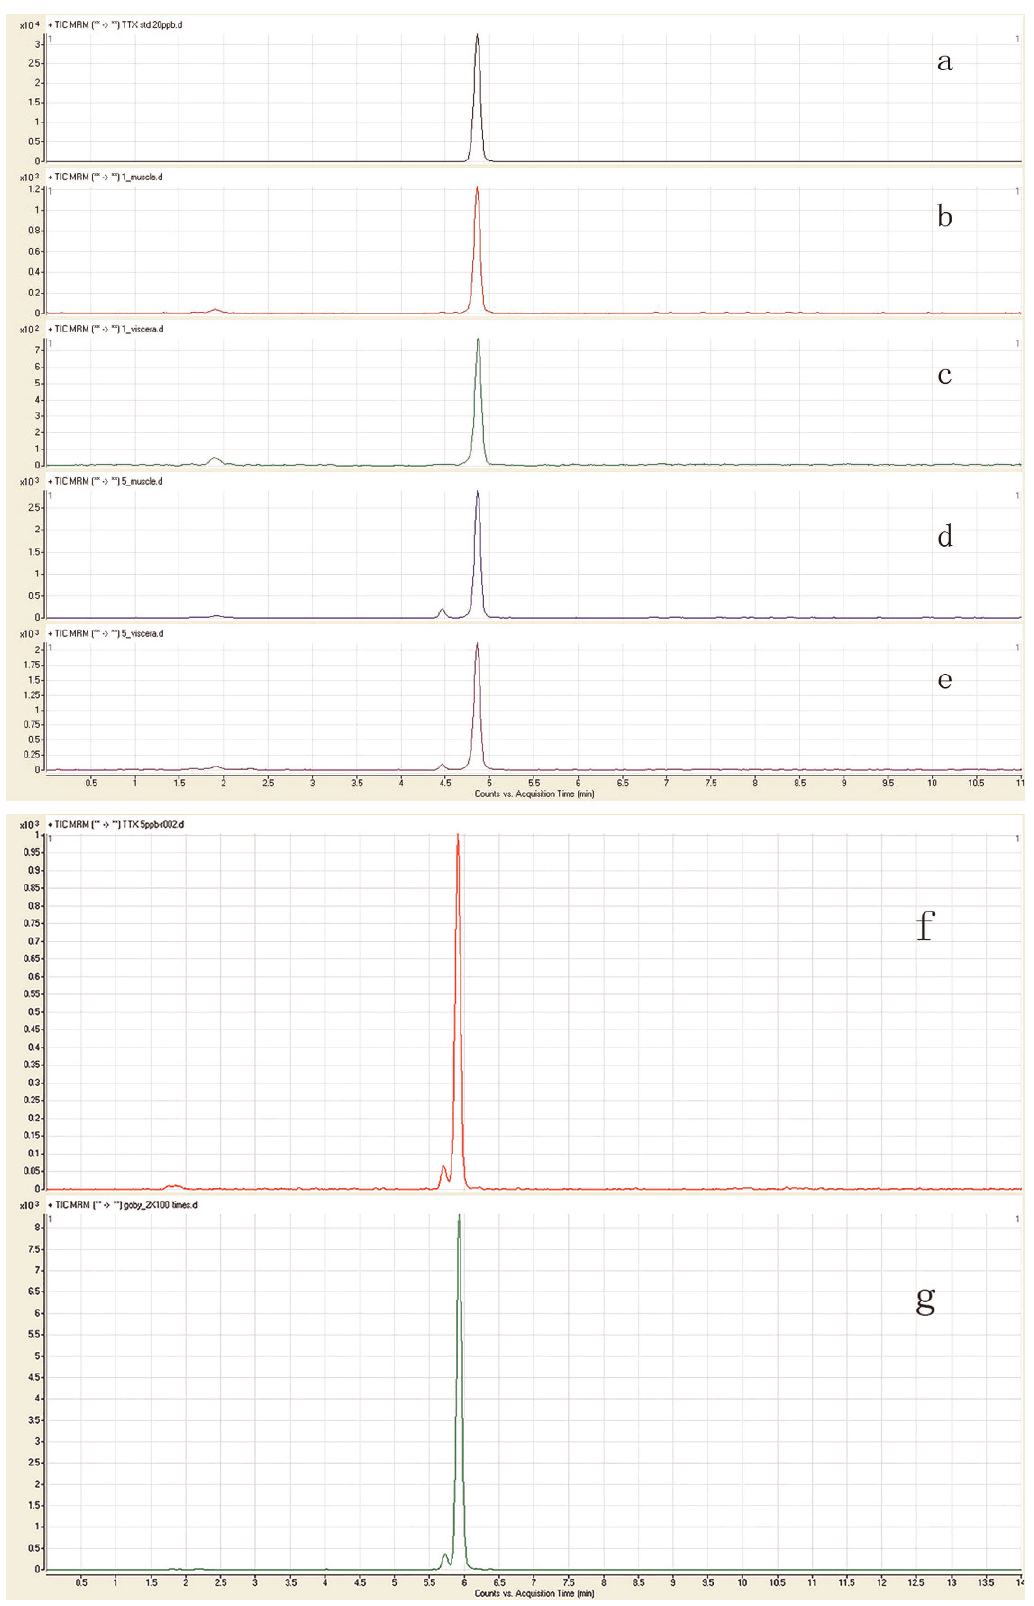
Figure 1 - The figure MRM chromatogram of TTX standard and Goby samples. (a) and (f): TTX standard; (b): muscle of Amoya caninus ; (c): viscera of Amoya caninus ; (d): muscle of Yongeichthys nebulosus ; (e): viscera of Yongeichthys nebulosus ; (g): remaining food sample of the prepared Goby